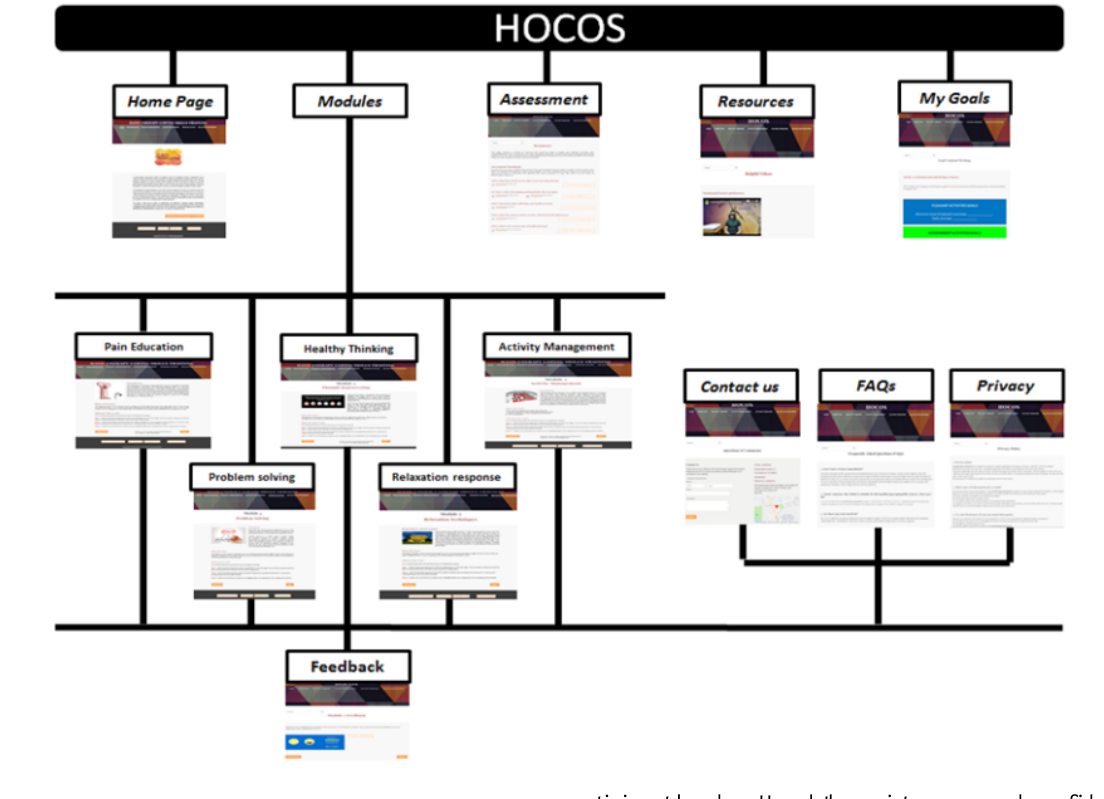
Figure 3. Screenshot of webpages showing the architecture of the website. FAQs: frequently answered questions; HOCOS: Hand Therapy Online Coping